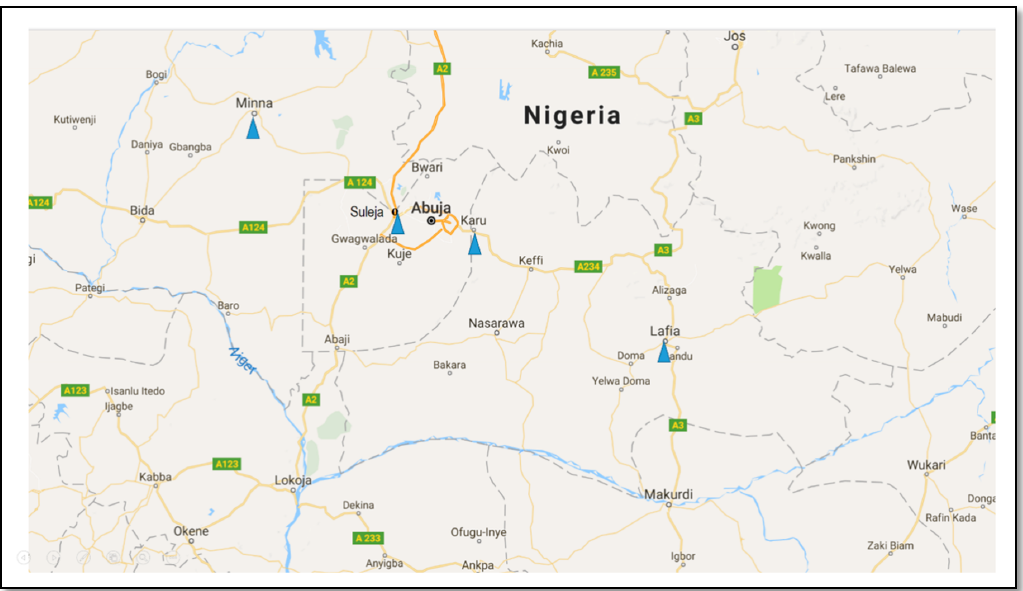
Figure 2. Map of the study region showing the location of the sites (blue rectangle). Source—Google Map of the study region showing the location of the sites (blue rectangle). maps. Source—Google